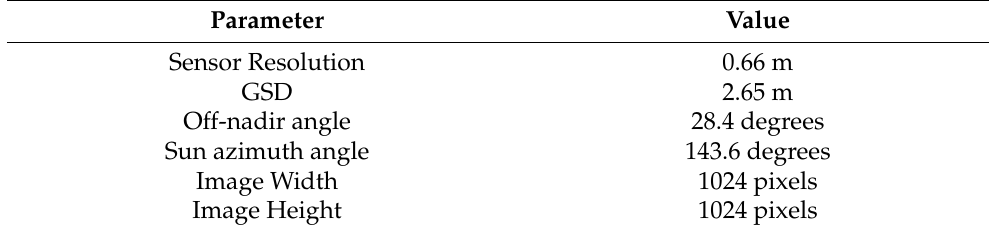
Table 2. Imagery technical specifications.